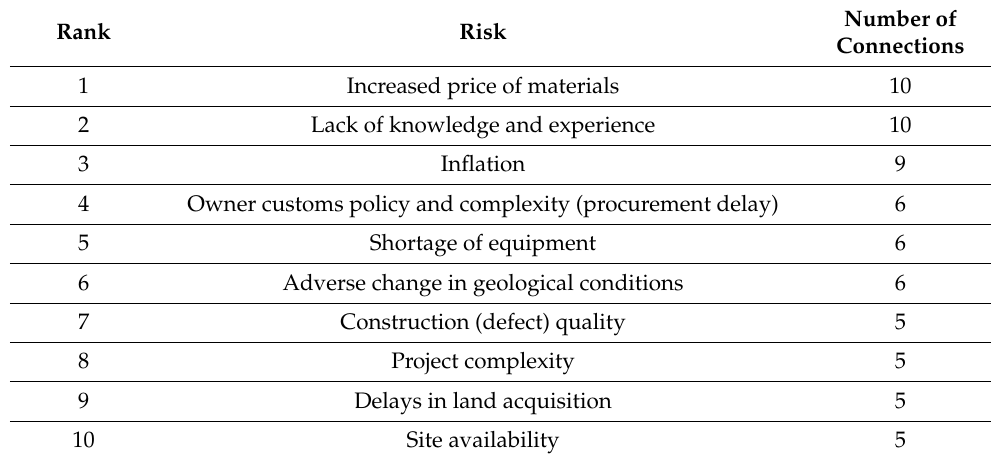
Table 8. Most critical risks.